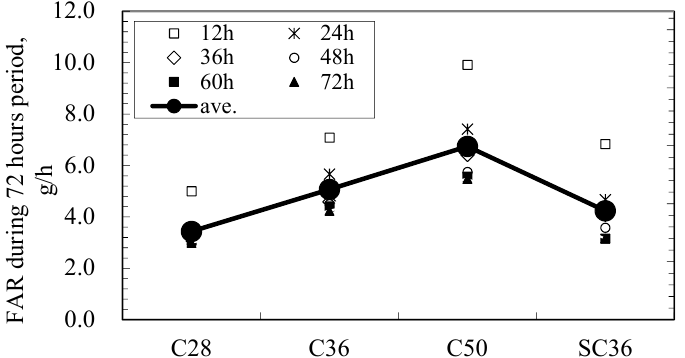
Figure 8. Friction abrasion rate (FAR) of concrete at different time during the 72 h period test.